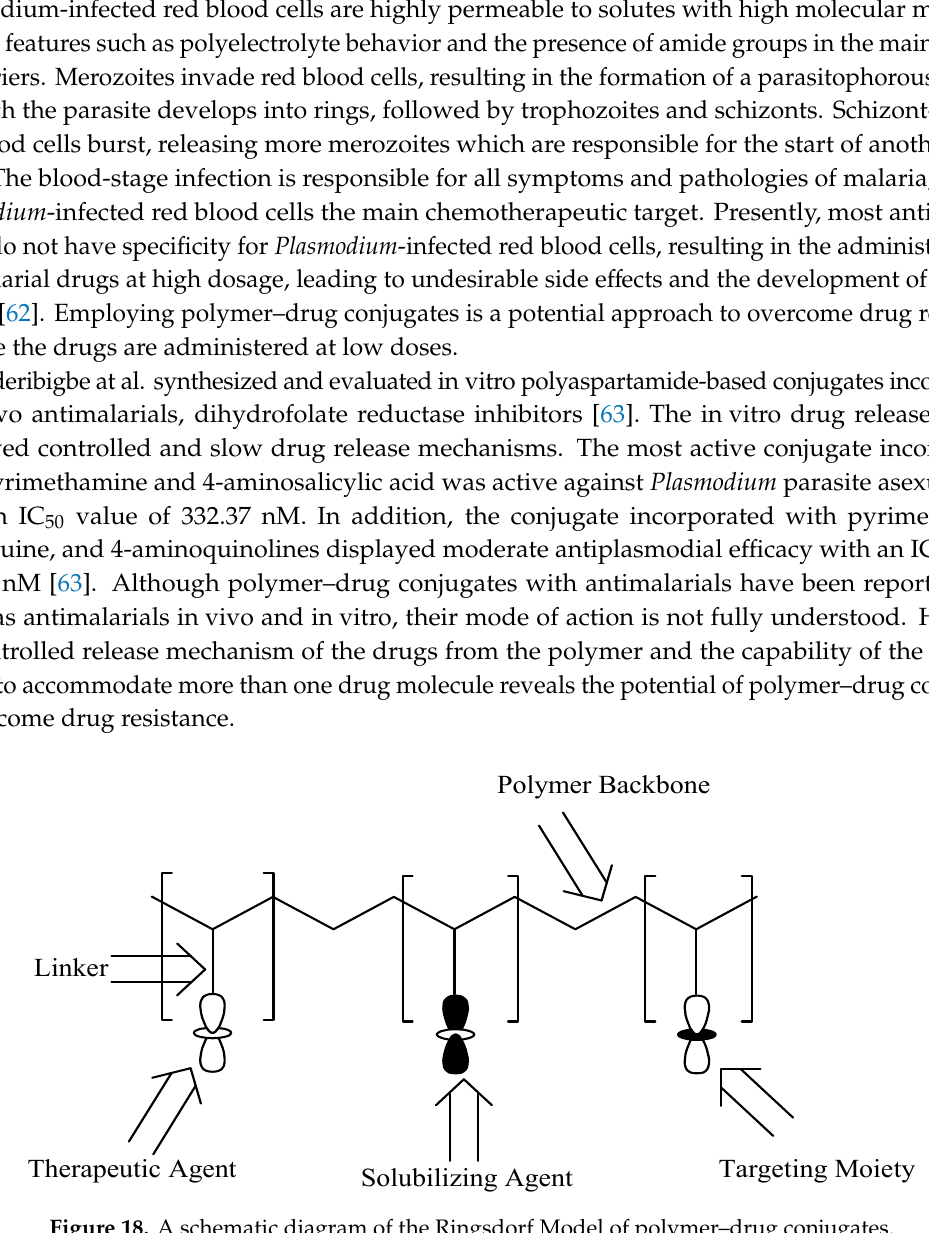
Figure 18. A schematic diagram of the Ringsdorf Model of polymer–drug conjugates.